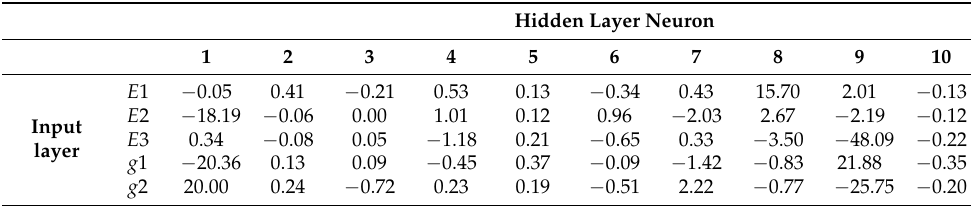
Table 5. Input layer to hidden layer weights for T2.